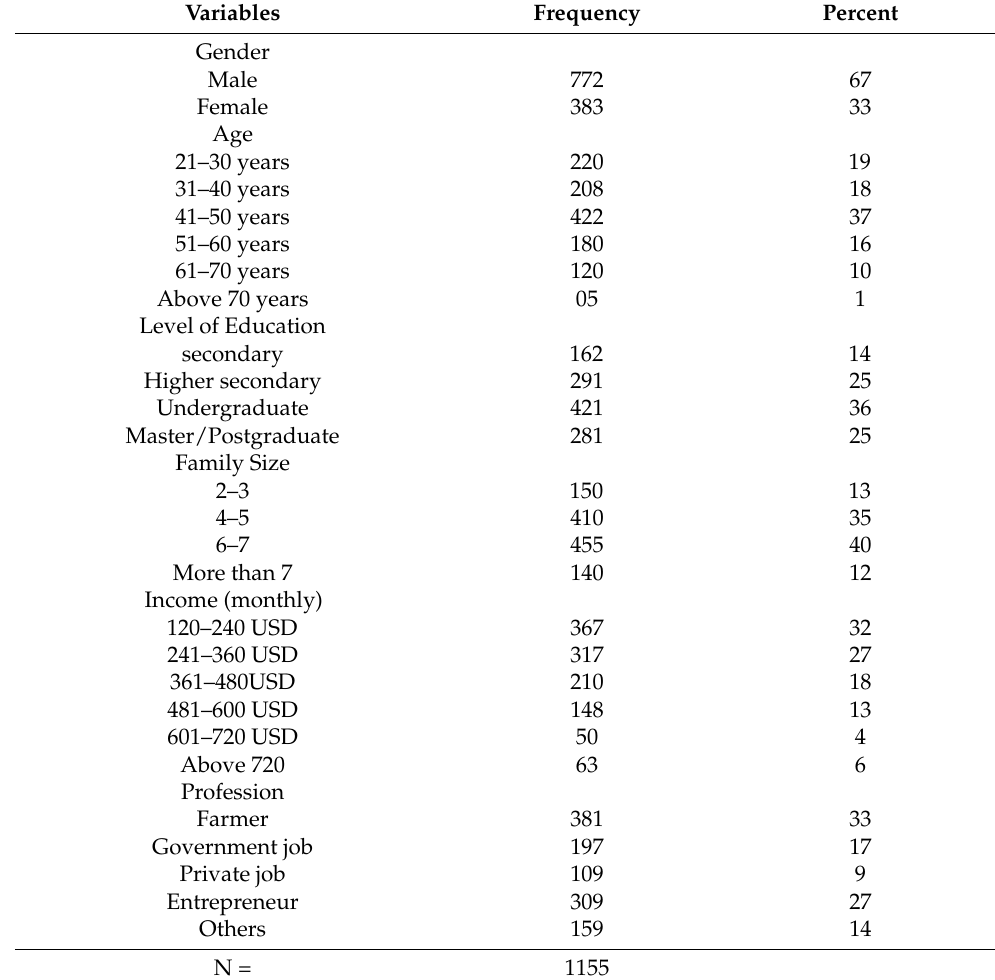
Table 2. The socio-demographic